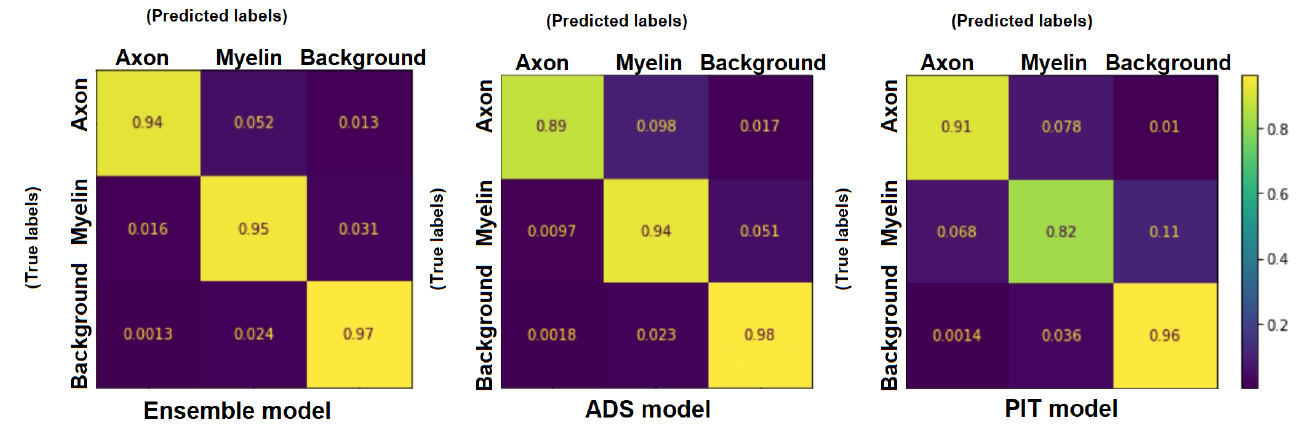
Figure 4. Confusion matrices of the ensemble, ADS, and PIT models.